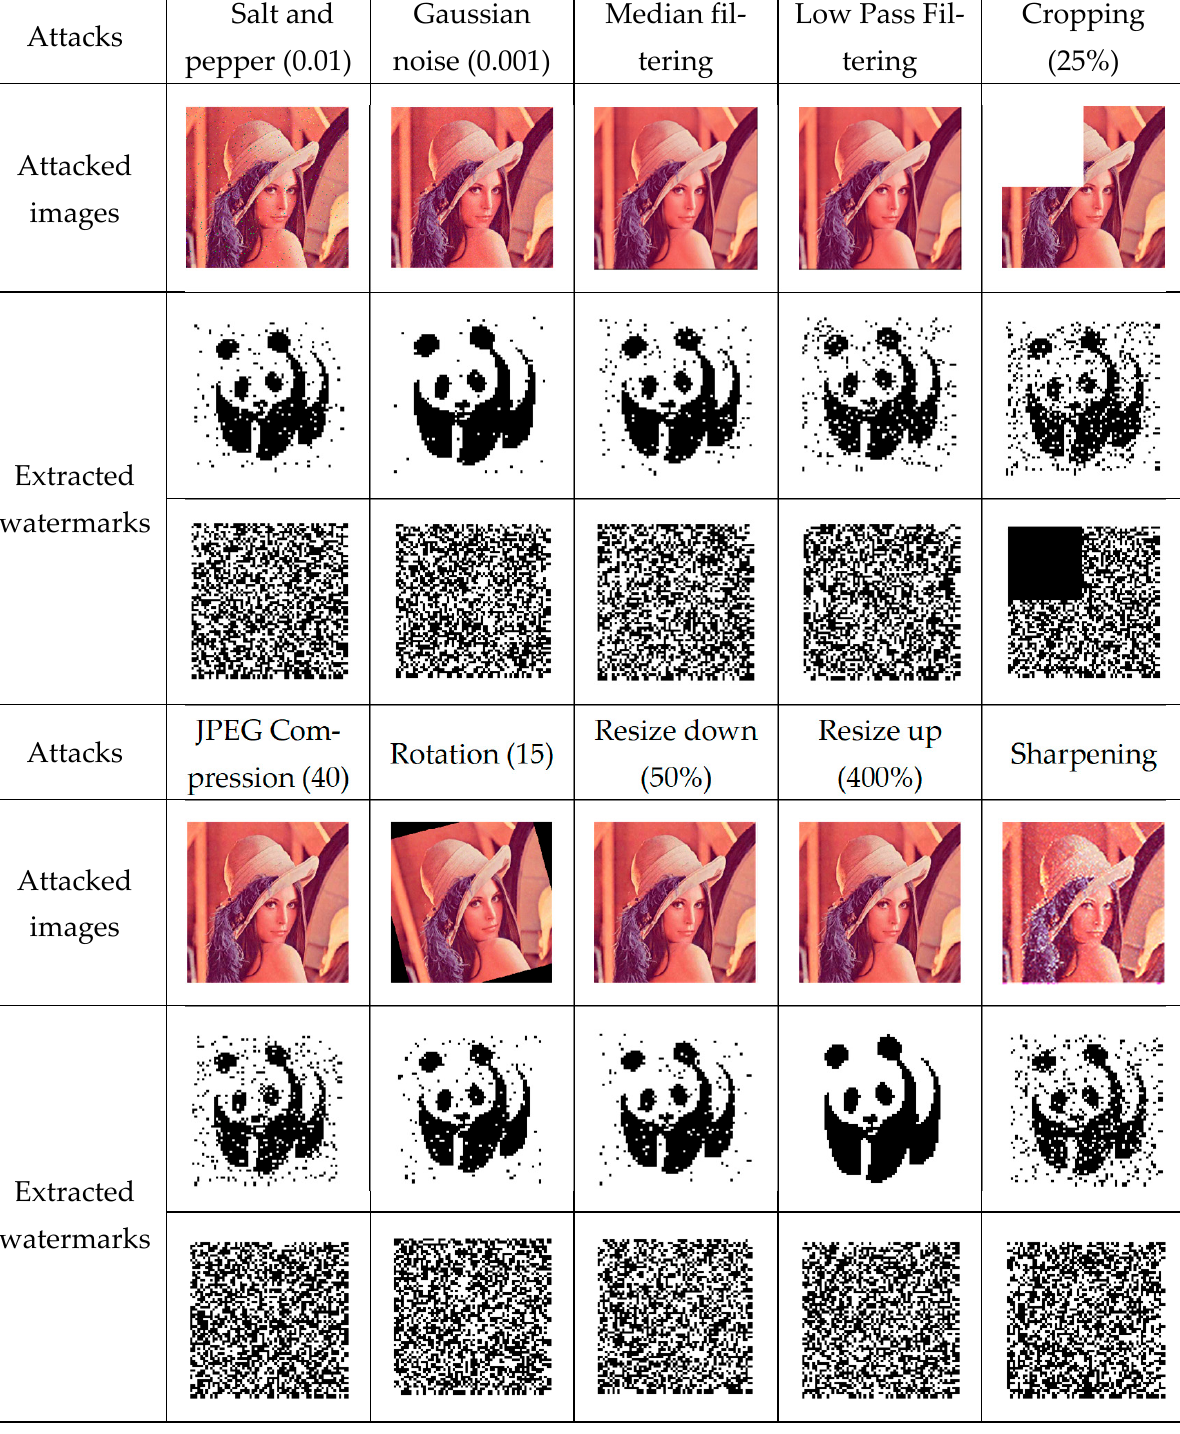
Figure 15. Double watermark image and extracted watermark image under multiple a tt acks . Table 3. Performance test of robust watermark and fragile watermark extracted under single a tt ack .